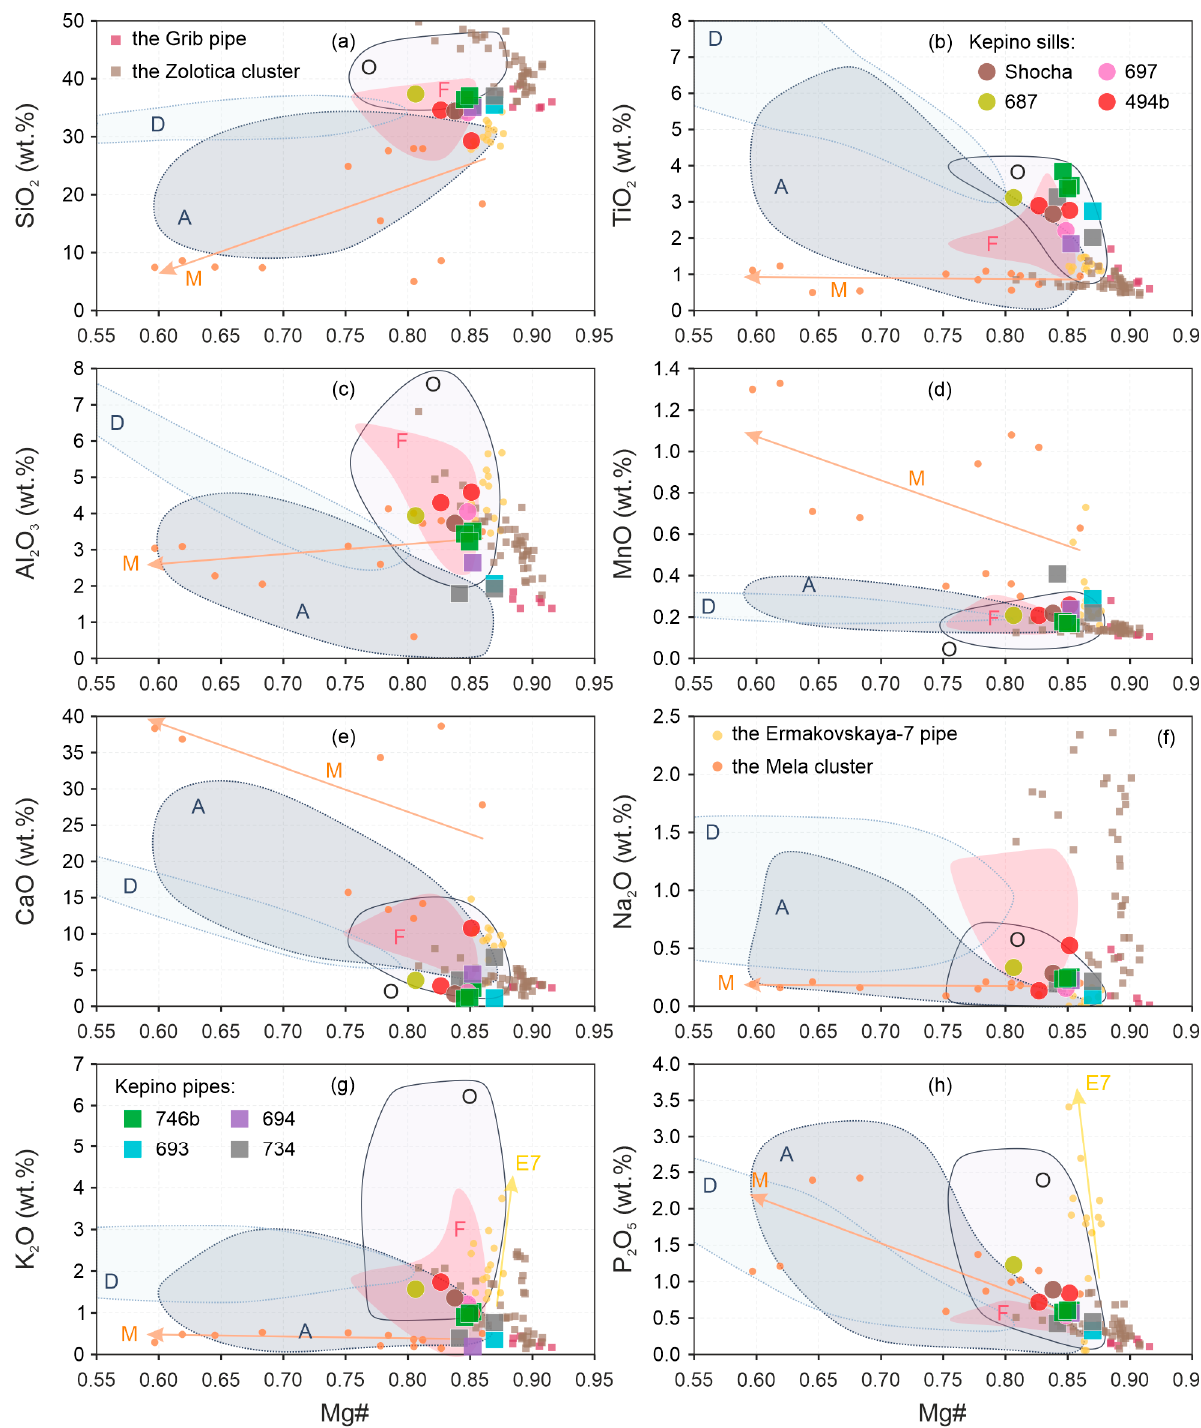
Figure 11. Binary diagrams SiO 2 vs. Mg# ( a ), TiO 2 vs. Mg# ( b ), Al 2 O 3 vs. Mg# ( c ), MnO vs. Mg# ( d ), CaO vs. Mg# ( e ), Na 2 O vs. Mg# ( f ), K 2 O vs. Mg# ( g ), P 2 O 5 vs. Mg# ( h ) representing the major element composition of Kepino cluster kimberlites in comparison with